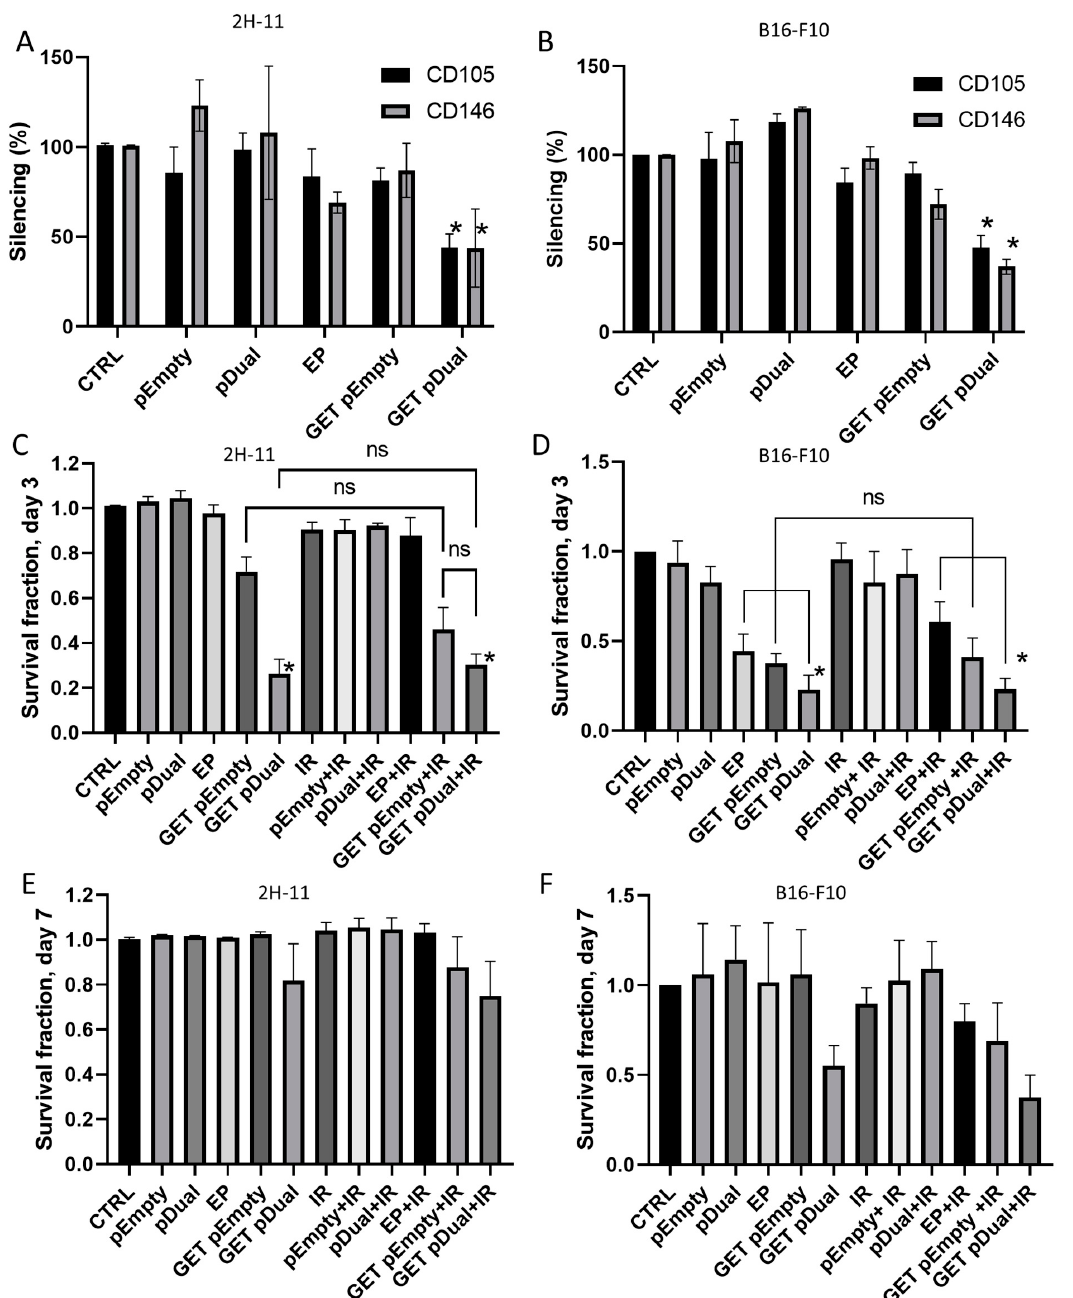
Figure 2. Silencing and cytotoxicity of pU6-anti-CD105-146-ORT GET. ( A ) Silencing of CD105 and CD146 after GET of pU6-anti-CD105-146-ORT plasmid in 2H-11 cells and ( B ) in B16-F10 cells. *, unpaired t test vs. CTRL ( p < 0.05). ( C ) Cell survival after GET of pU6-anti-CD105-146-ORT plasmid alone or combined with IR on day 3 in 2H-11 cells and in ( D ) B16-F10 cells. ( E ) Cell survival after GET of pU6-anti-CD105-146-ORT plasmid alone or combined with IR on day 7 in 2H-11 cells and in ( F ) B16-F10 cells. Bars represent the mean ± standard error of mean for three independent experiments. Values are normalized to the control group. *, statistically significant difference vs. all groups ( p < 0.05). ns, statistically non-significant difference. Group names: CTRL—untreated cells, pEmpty—treatment with pEmpty-ORT plasmid alone, pDual—treatment with pU6-anti-CD105-146-ORT plasmid alone, EP—application of electric pulses alone, GET pEmpty—GET of